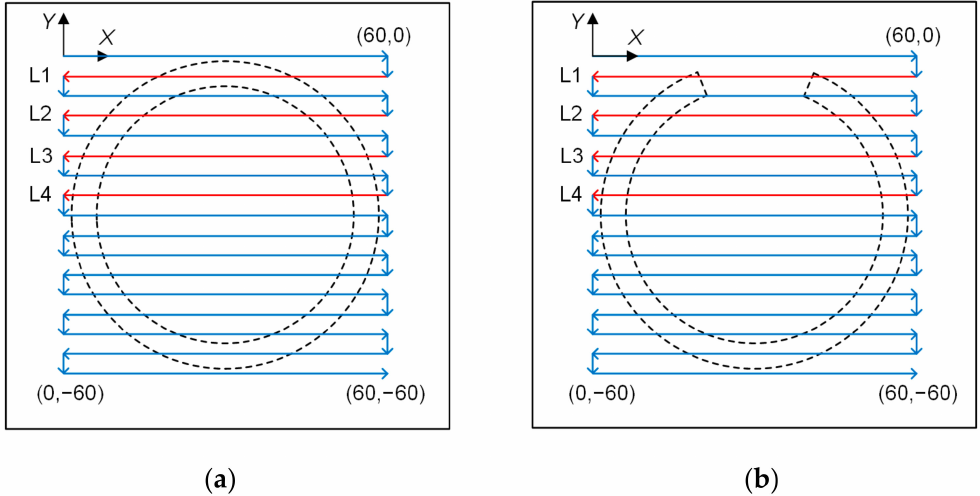
Figure 9. Illustration of the two-dimensional C-scan of the probe above ( a ) an intact foil and ( b ) an incomplete foil,